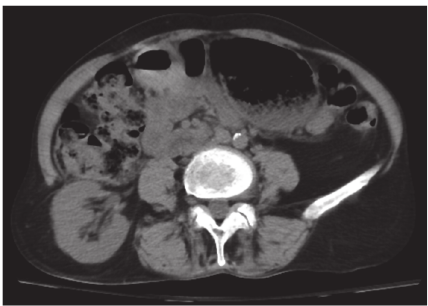
Figure 3: Axial CT demonstrates the extent of kidney